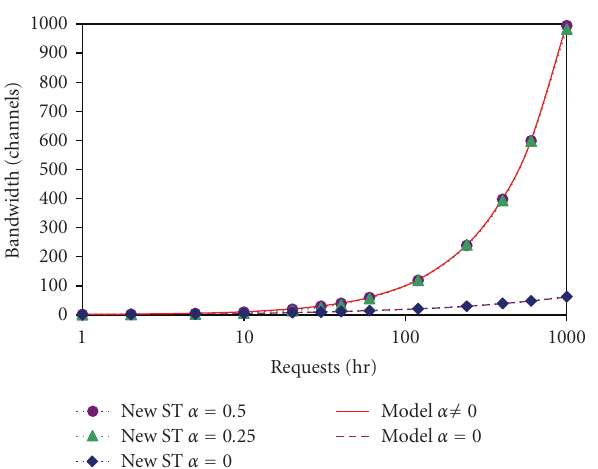
Figure 9: Network bandwidth requirements of the new stream tapping protocol.